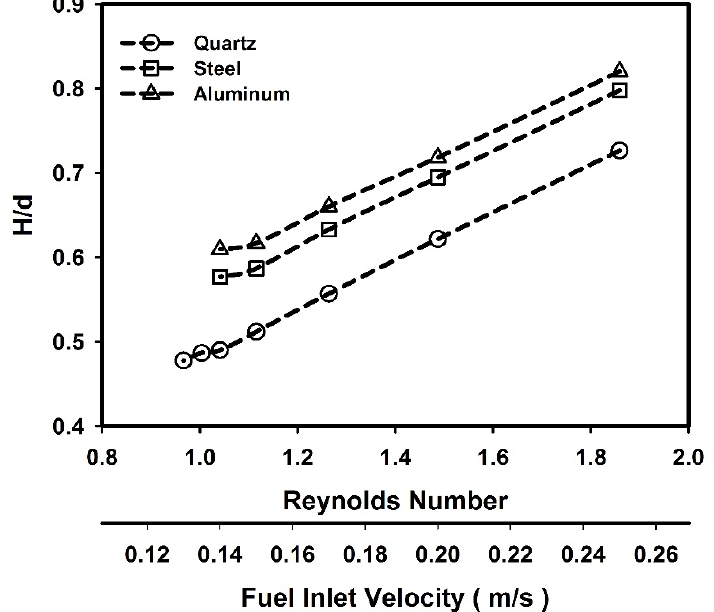
Figure 6. Variation of non-dimensional flame heights with fuel inlet velocity for quartz, steel, and aluminum